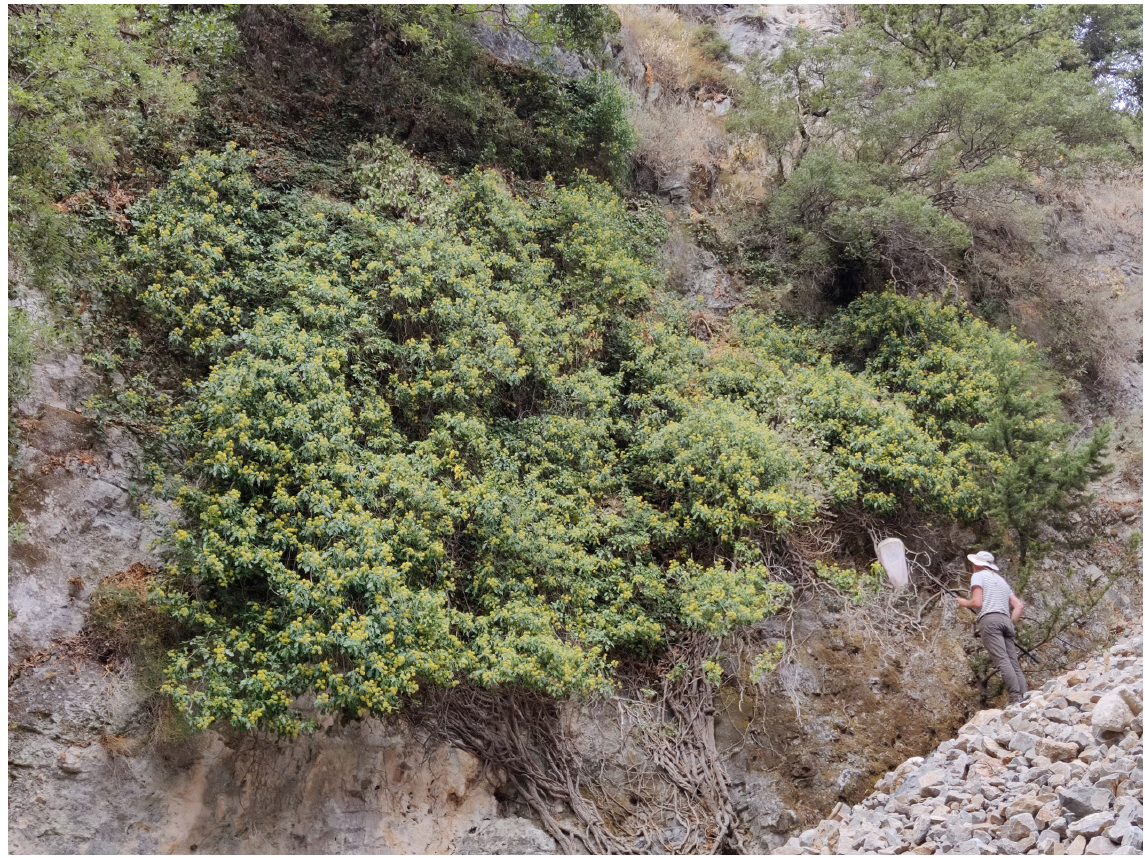
Fig. 8. Type locality of Milesia cretica Bot & van Steenis sp. nov. with flowering Hedera helix L.: Imbros Gorge, Crete, Greece, October 8, 2021 (photo Sander